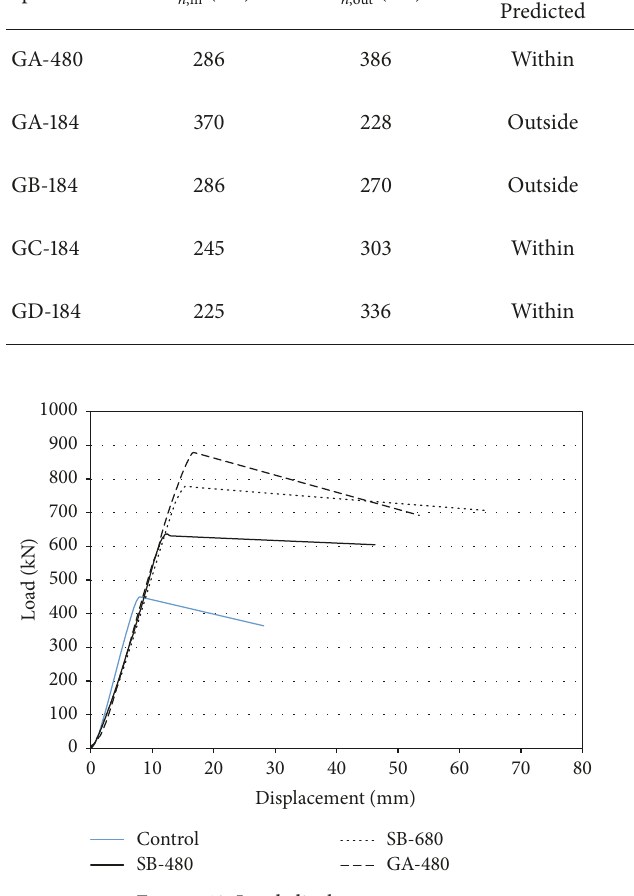
Figure 12: Load-displacement curves.